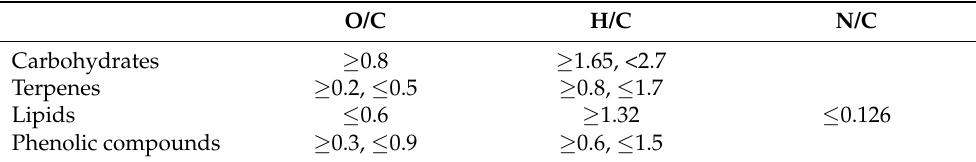
Table 1. Area of molecular families on the van Krevelen diagram [34,35]. O/C H/C N/C Carbohydrates ≥ 0.8 ≥ 1.65, <2.7 Terpenes ≥ 0.2, ≤ 0.5 Lipids Phenolic